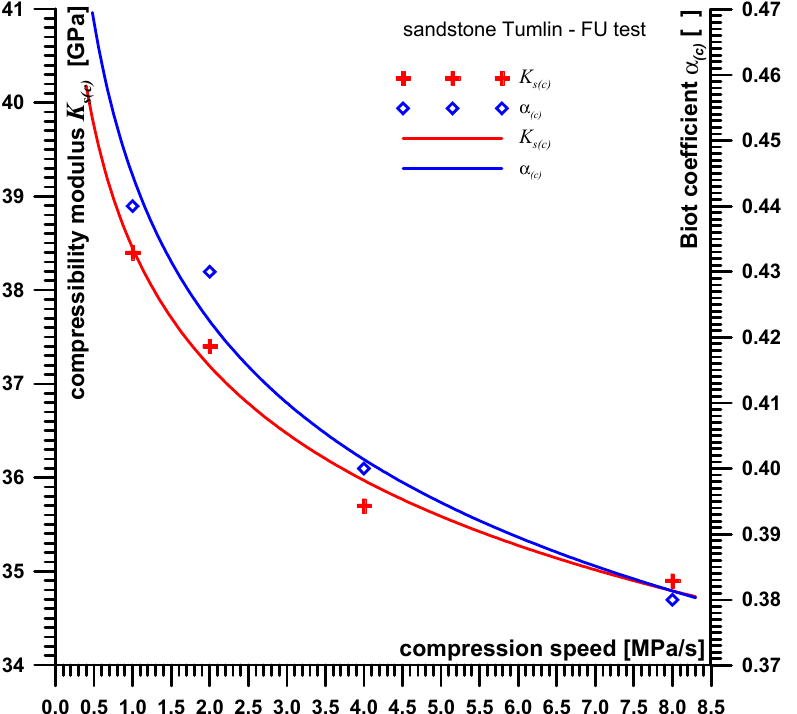
Figure 11. Relationship between the values of the α coefficient and K s modulus and the compression rate—FU test; Tumlin sandstone.